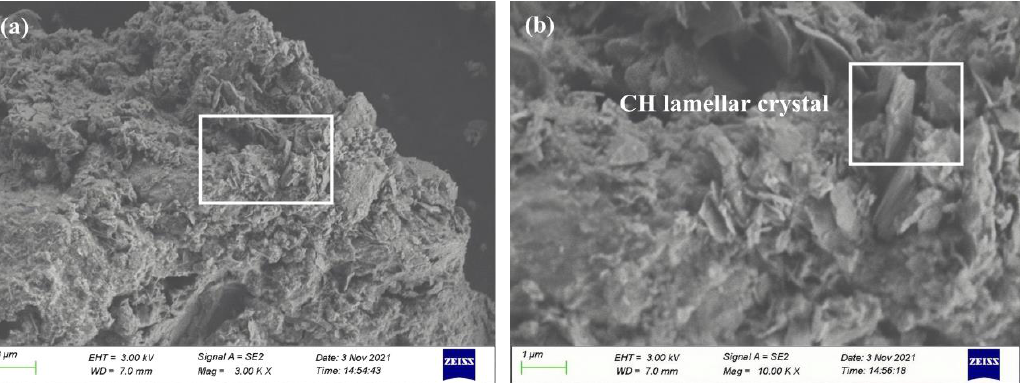
Figure 8. Ordinary-cemented soil cured for 7 d. ( a ) (3.00 kx magnification) and ( b ) (10.00 kx magnification).